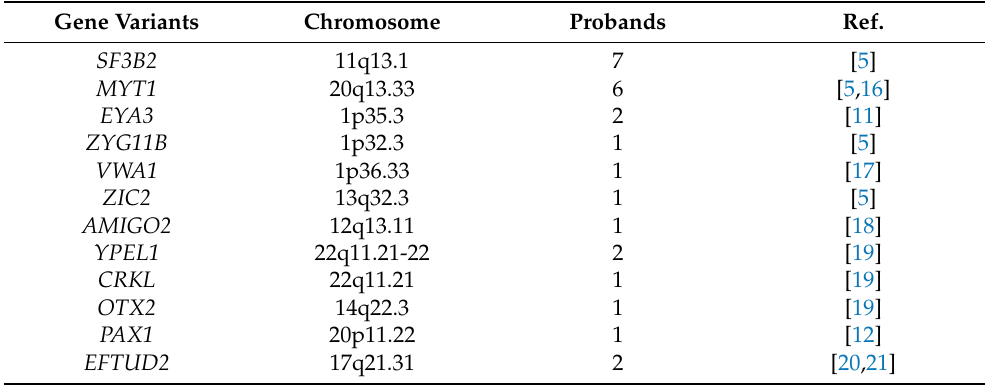
Table 1. Genes with variants associated with OAVS.